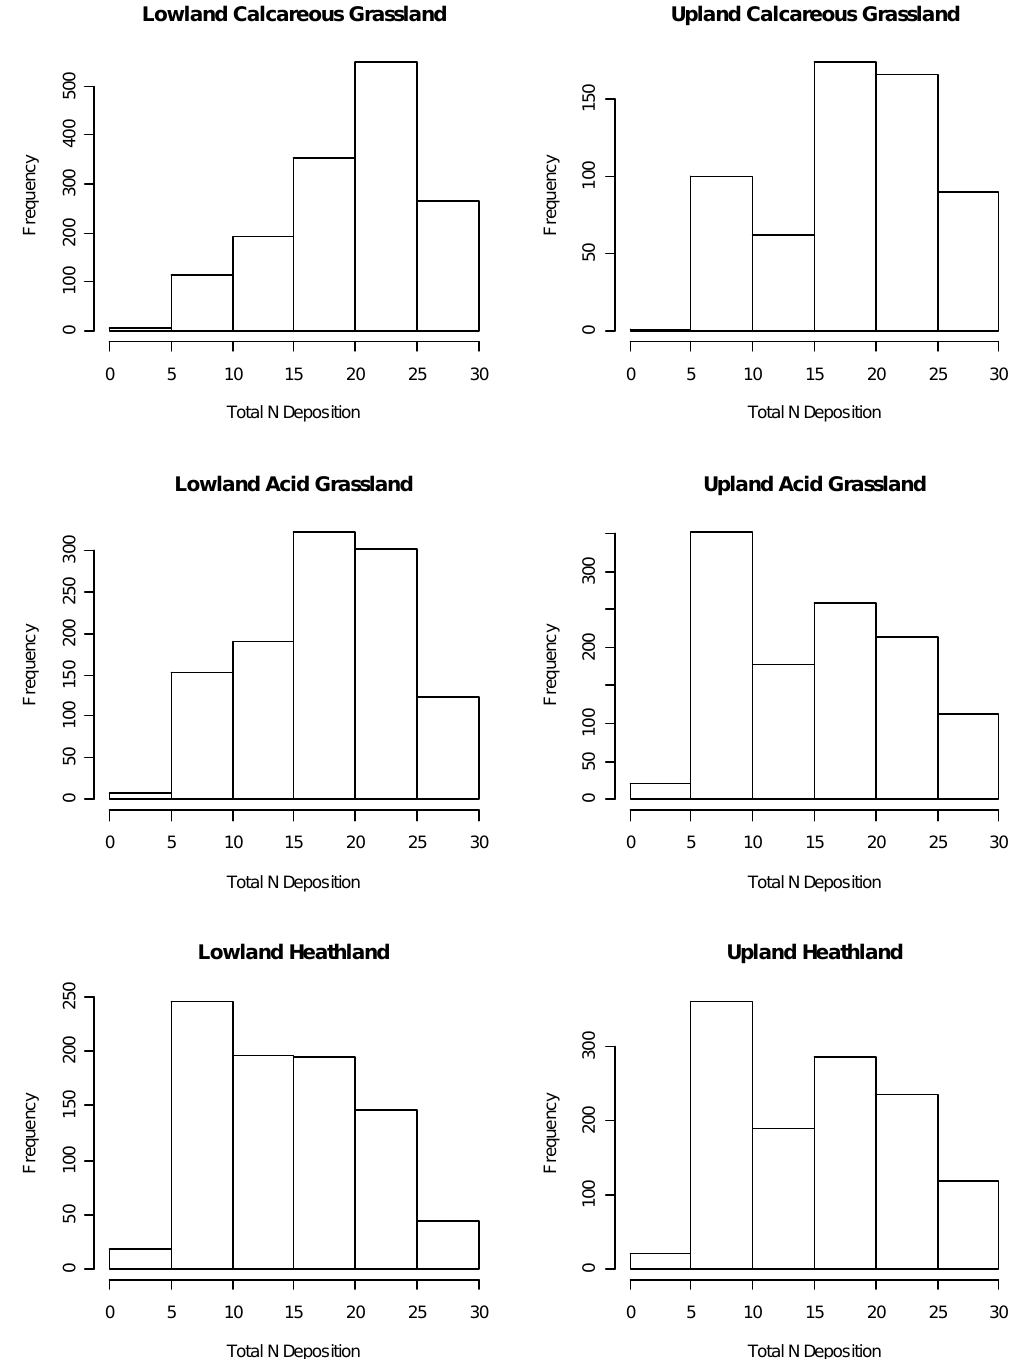
Fig. A1. Histograms showing the distribution of N deposition in the Vascular plant database between 0–30kgNha − 1 yr − 1